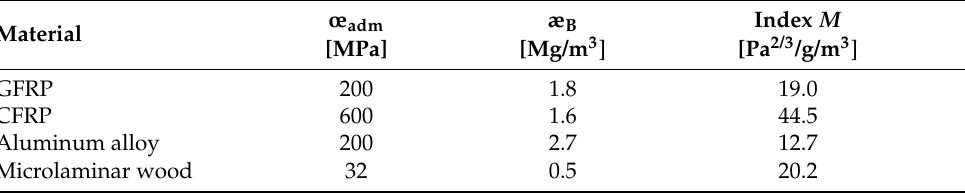
Table 2. Material and shape selection for a light and resistant